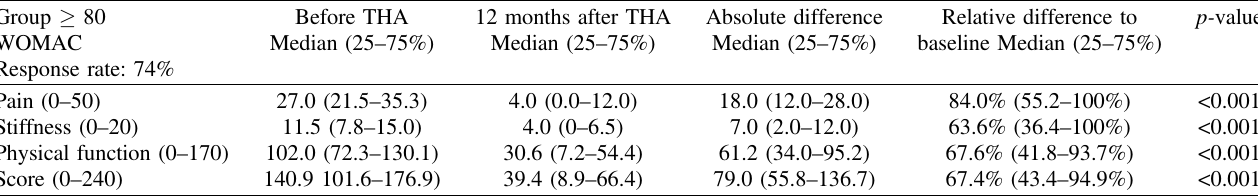
Table 4. WOMAC score and items before and after THA in the group (cid:3) 80.